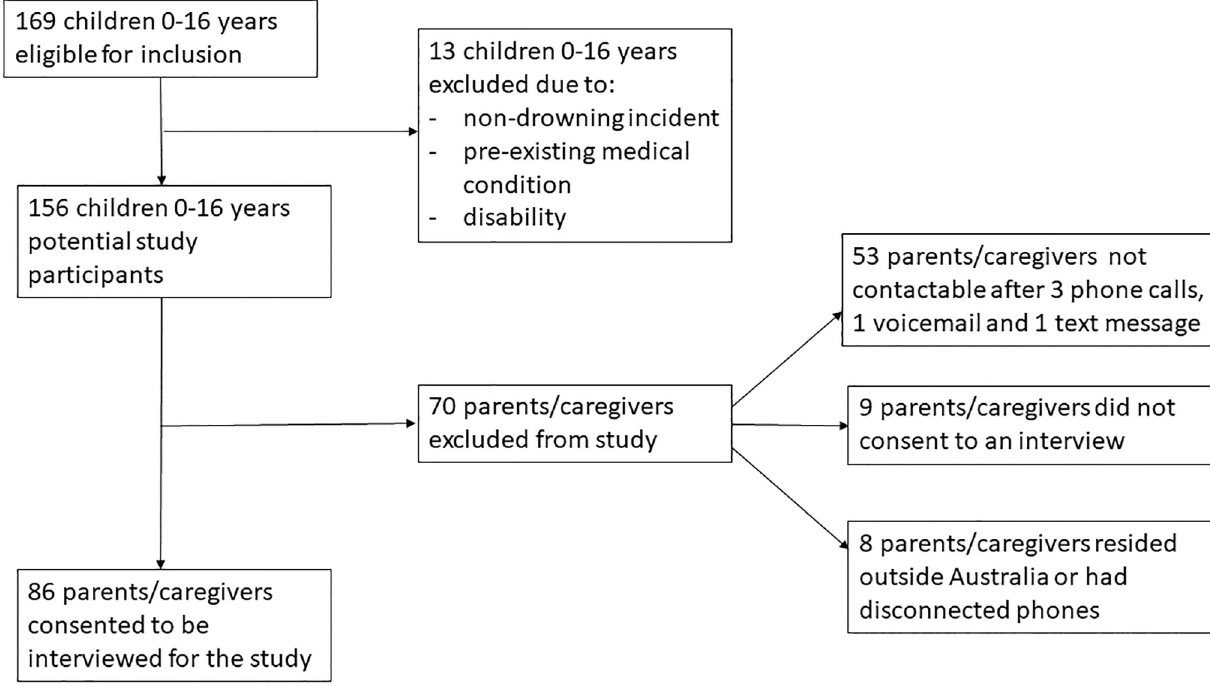
Fig 1. Flow chart of participant eligibility and